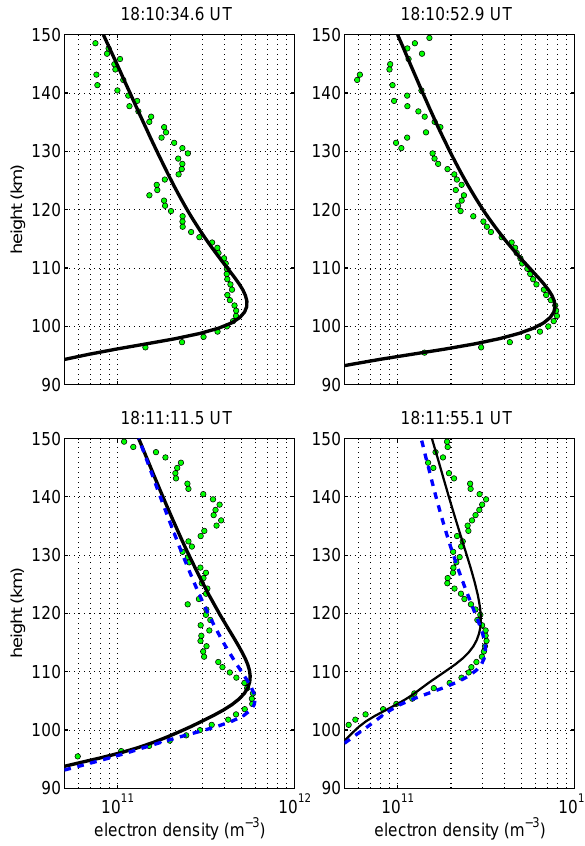
Fig. 7. Comparison of individual profiles of modelled electron den- sity with radar measured